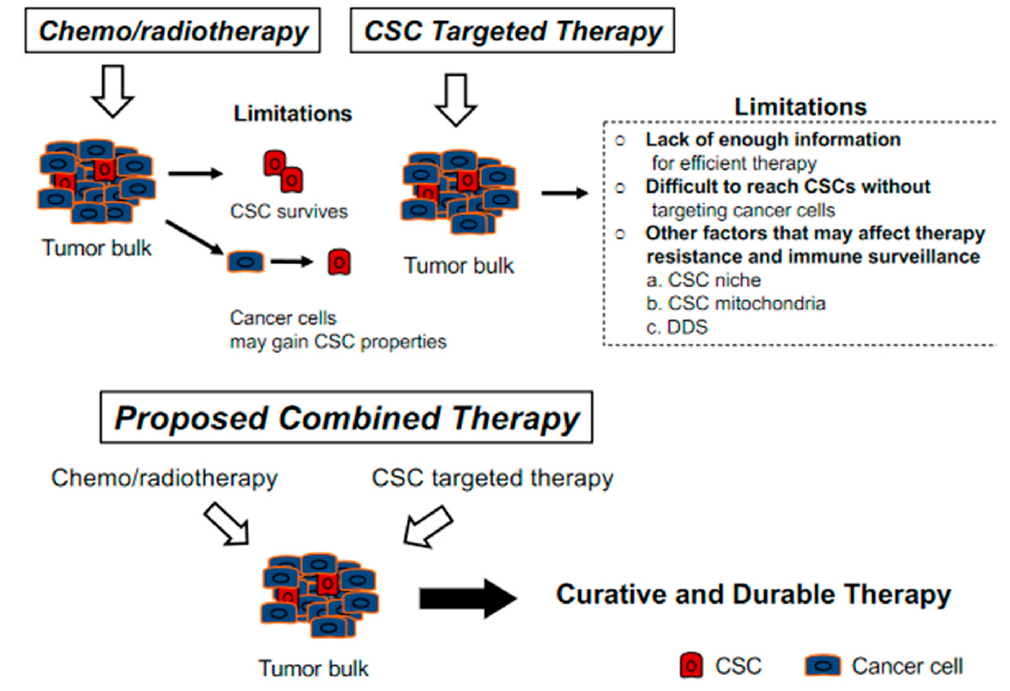
Figure 2. There are difficulties in each of conventional chemoradiotherapy and cancer stem cell (CSC) targeted therapy. While chemoradiotherapy leaves CSC untouched, CSC-targeted therapy leaves large tumor bulk with cancer cells, which may then gain CSC properties. Moreover, heterogeneity in various CSCs is another challenge to overcome.